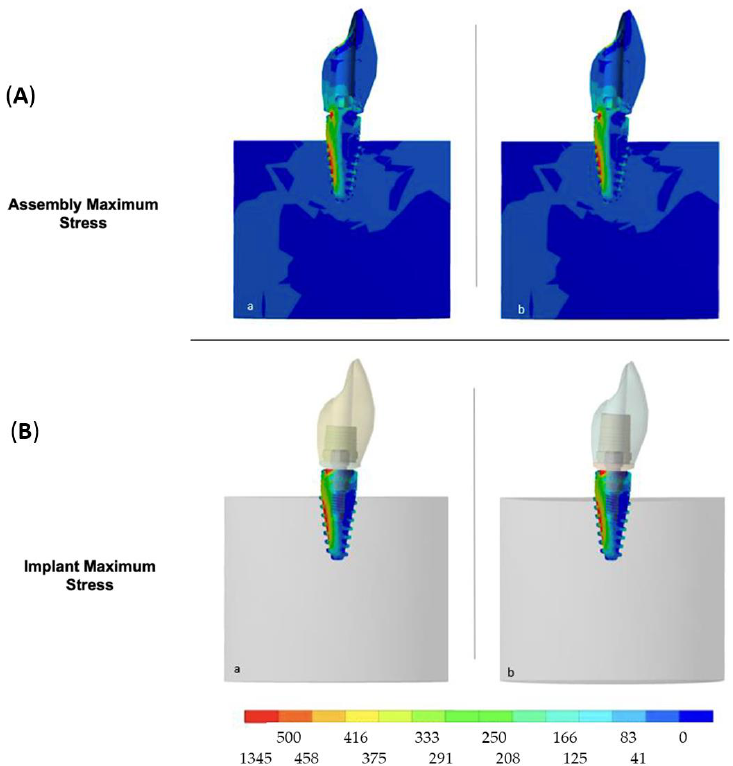
Figure 11. ( A ) Stress concentration in the assembly with short ( a ), and long ( b ) abutments; and ( B ) stress concentration in the implant with a short abutment ( a ), and long abutment ( b ). The stress in the prosthetic screw suggests that in both models, this structure is prone to failure (Figure 12). Additionally, similar behavior of the prosthetic screw can be observed from the visual plot in both groups in terms of stress distribution.